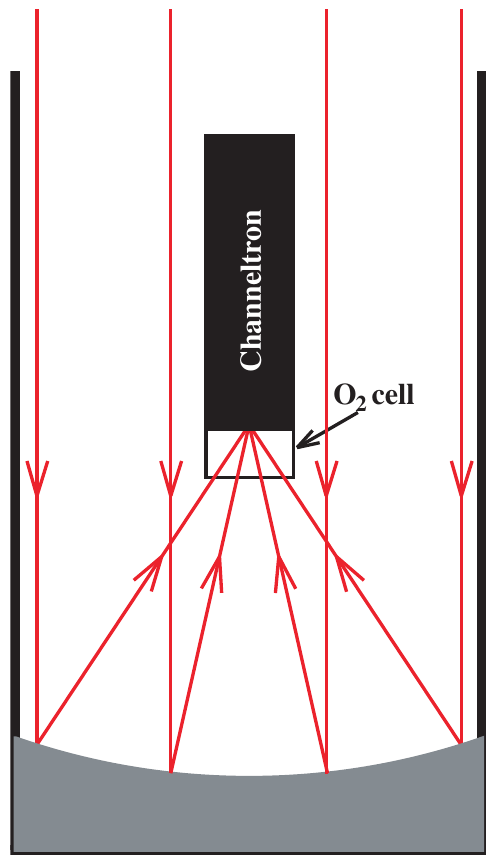
Figure 10 . Schematic of a filter photometer for the measurement of Lyman- α . The design Fig. 9. The open SLAM instrument (without the cover plate) com- Fig. 10. Schematic of a filter photometer for the measurement of plete with gratings, photomultiplier tube, and electronics, the en- Lyman- α . The design is based on a Cassegrain setup with a channel is based on a Cassegrain setup with a channel electron multiplier (channeltron) as trance is to the right and an additional sun sensor is to the left. electron multiplier (channeltron) as detector. After the mirror the detector. After the mirror the light enters an O cell which absorbs radiation up to 180 nm light enters an O 2 cell which absorbs radiation up to 180nm except 2 the Lyman- α line at 121.57nm. A channeltron with a KBr coated except the Lyman- α line at 121.57 nm. A channeltron with a KBr coated photocathode photocathode blocks wavelengths longer than blocks wavelengths longer than 160 nm.